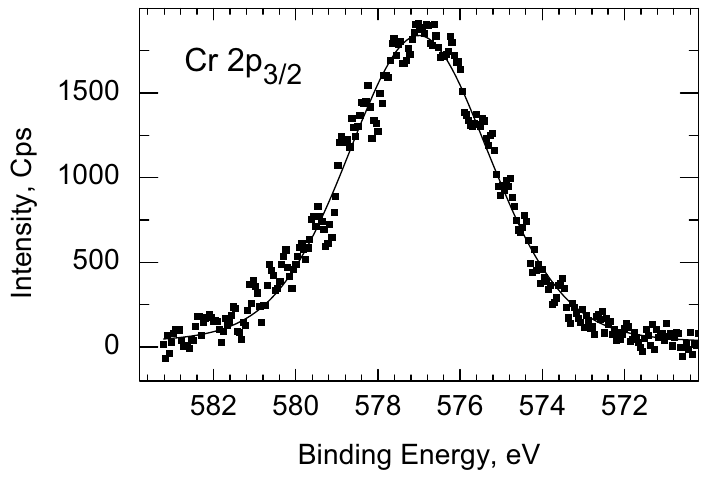
Fig. 4 XPS Cr 2p 3 / 2 spectra of ODA-clinoptilolite with adsorbed